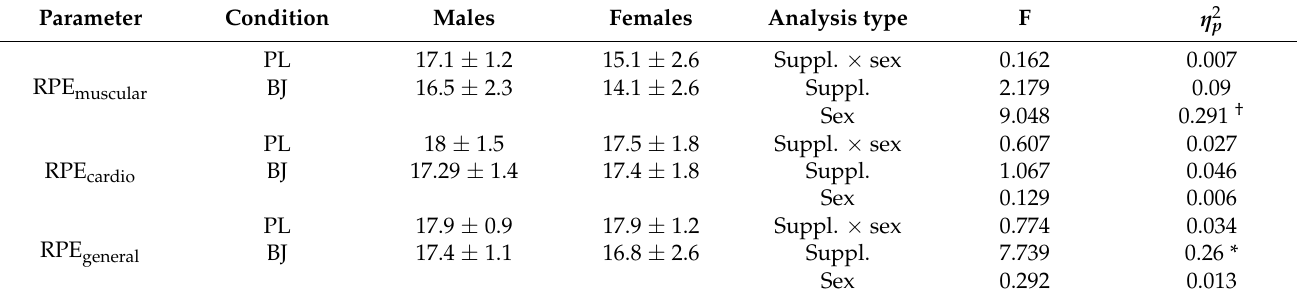
Table 3. Effect of nitrate-rich and nitrate-depleted beetroot juice supplementation on ratings of perceived exertion (RPE) responses after a 2 km running time